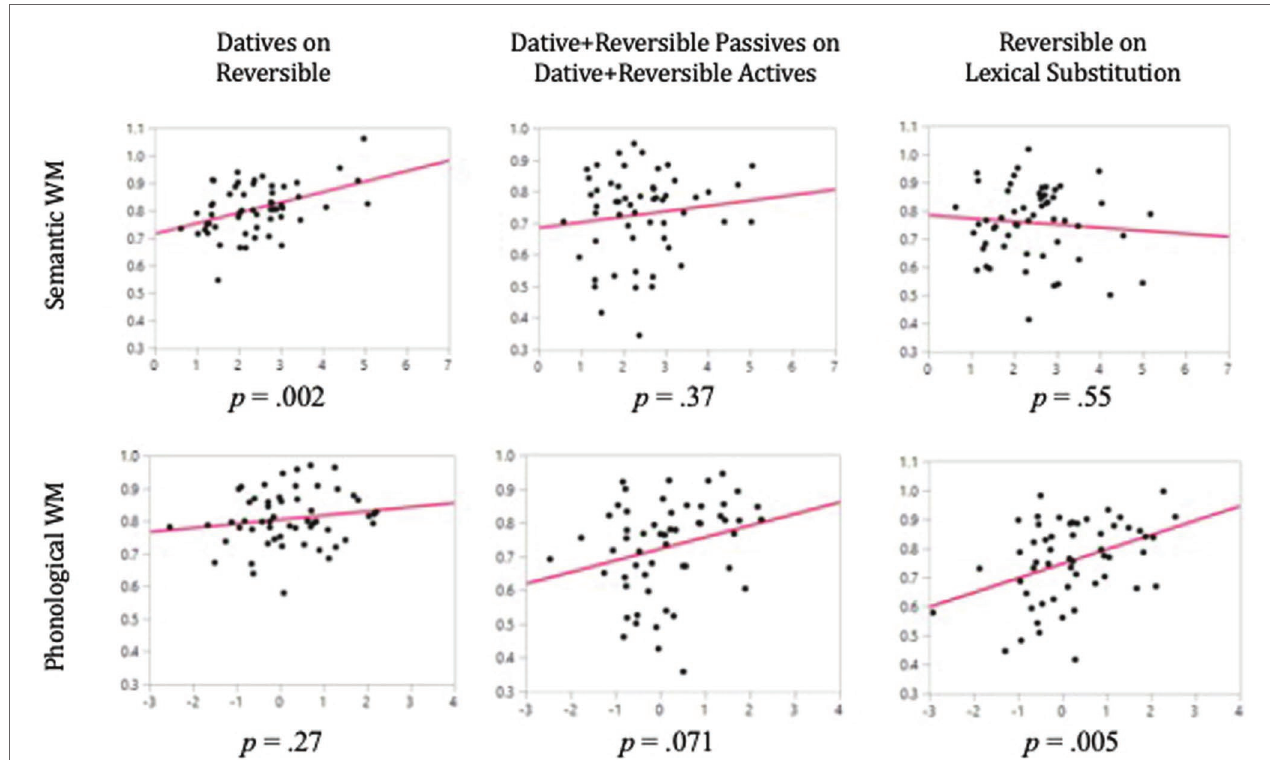
FIGURE 4 | Effect leverage plots for the individual contributions of semantic and phonological WM in three models predicting performance on the active-passive sentence comprehension task. In all plots, the Y -axis represents sentence comprehension performance after all other effects included in the model have been factored out. The X -axis represents WM performance (semantic WM along the top row and phonological WM along the bottom) after all other effects included in the model have been factored